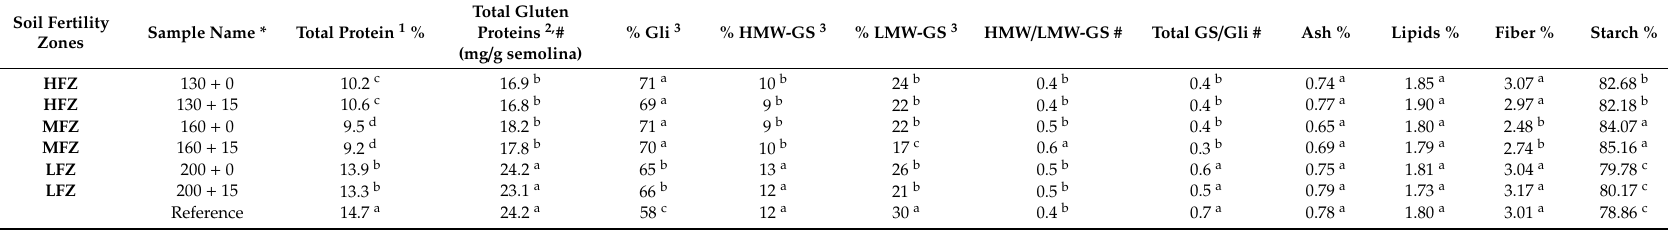
Table 1. Proximate composition (expressed as g 100 / g of dry matter), gluten proteins quantification, and relative percentage of the three classes of gluten proteins (gliadins (Gli), high-molecular-weight glutenins (HMW-GS) and low-molecular-weight glutenins) (LMW-GS) of site-specific semolina samples of cv. Biensur compared with the commercial reference cv. Aureo . Data are referred to the 2011–2012 cultivation season. Soil Fertility